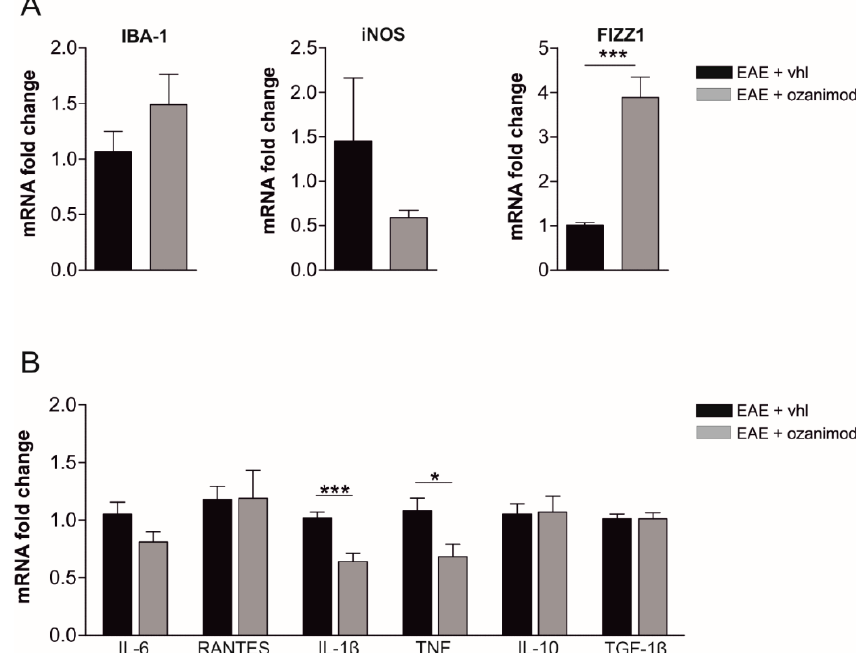
Figure 2. Ex vivo treatment of EAE corticostriatal slices with ozanimod modulates inflammatory related to microglial activation and lowers IL-1 β and TNF mRNA levels. ( A ) qPCR quantification of microglial markers from EAE striatal slices incubated with ozanimod (1000 nM,2 h) shows a significant upregulation of the M2 marker FIZZ1 (resistin like alpha, Retnla) without changing the expression of iNOS (inducible nitric oxide synthetase) and IBA1 (binding adaptor molecule 1). ( B ) qPCR quantification of cytokines from EAE striatal slices incubated with ozanimod (1000 nM, 2 h) shows a significant downregulation of IL-1 β and TNF mRNAs. All data are expressed as mean ± SEM and as fold change of EAE vehicle samples. Unpaired t -test, * p < 0.05; *** p <